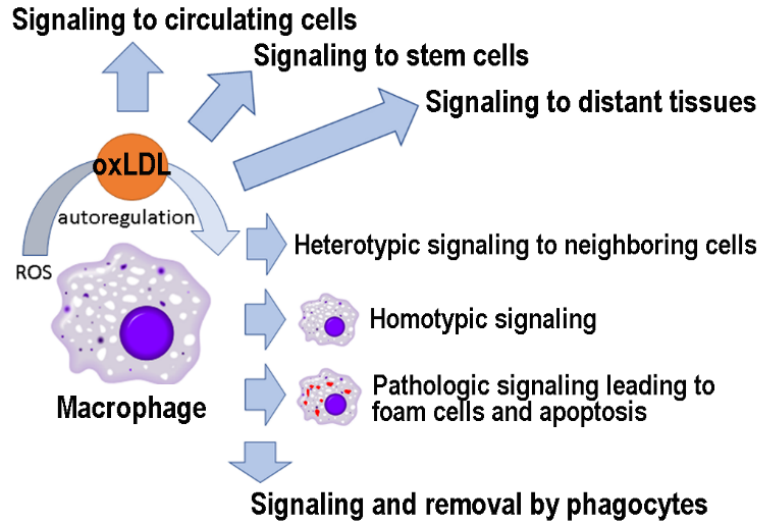
Figure 3. OxLDLs as signaling molecules to cells in different tissues.